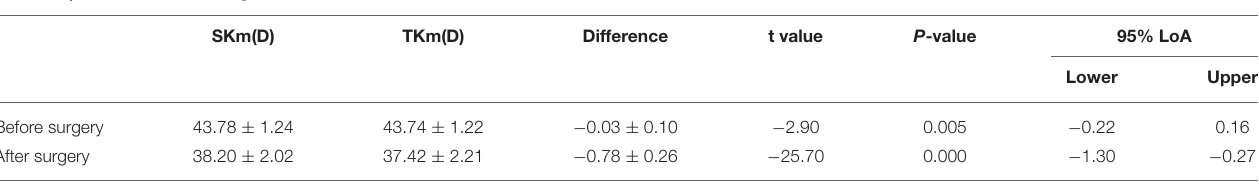
TABLE 2 | The differences and agreements between SK and TK.